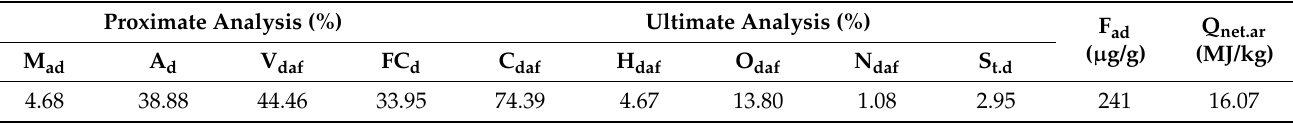
Table 2. Proximate and ultimate analysis